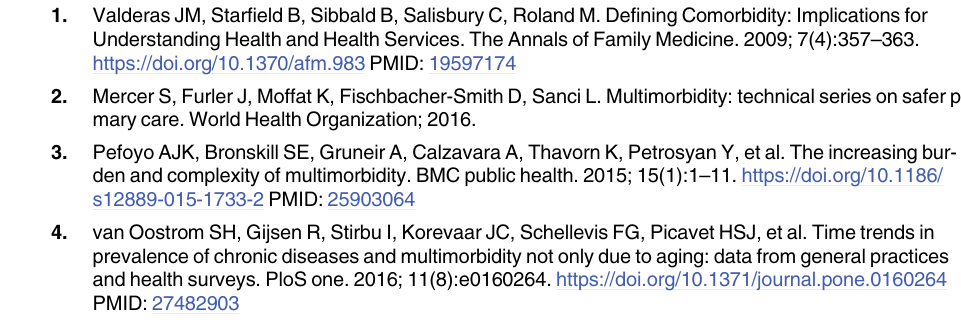
S16 Table. Parameter estimates for effects on obtaining diabetes as the next chronic dis- ease